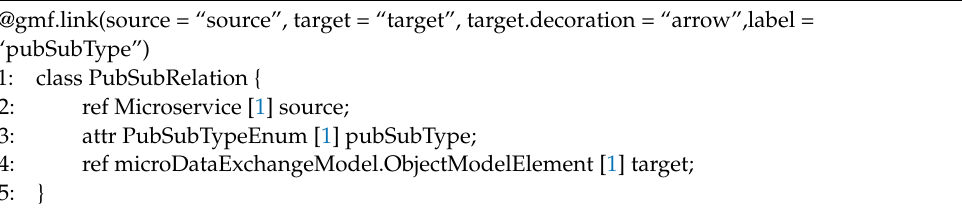
Algorithm 1 Sample Emfatic language for defining publish/subscribe